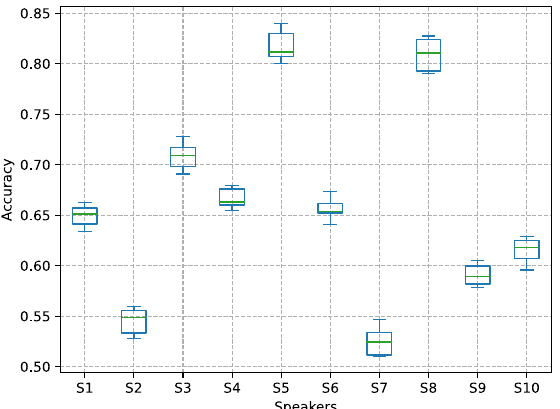
Figure 8. Per-speaker recognition accuracy on the AVLetters